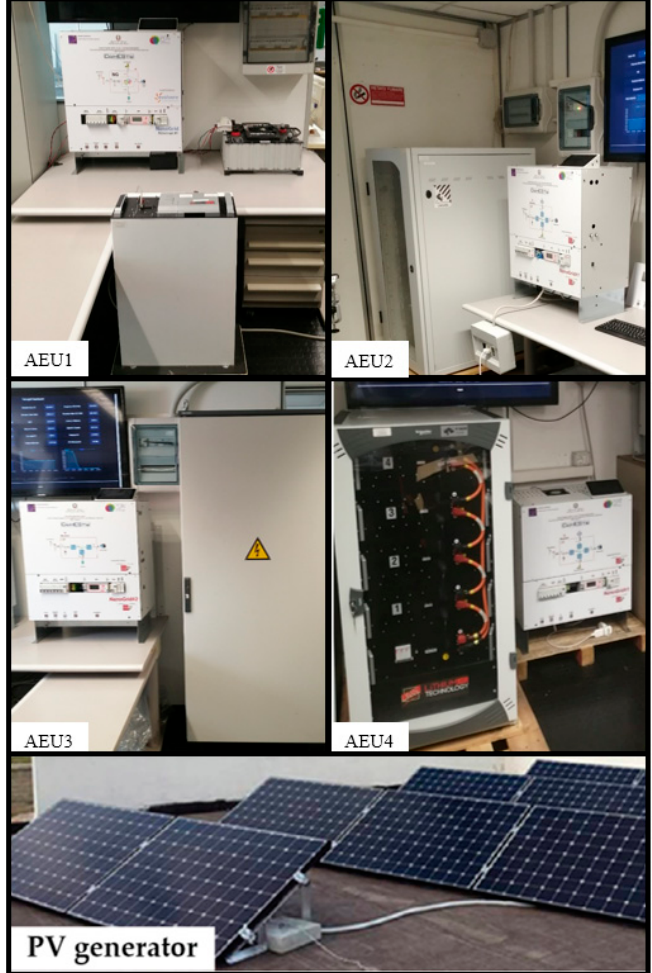
Figure 10. AEUs Laboratory prototypes.